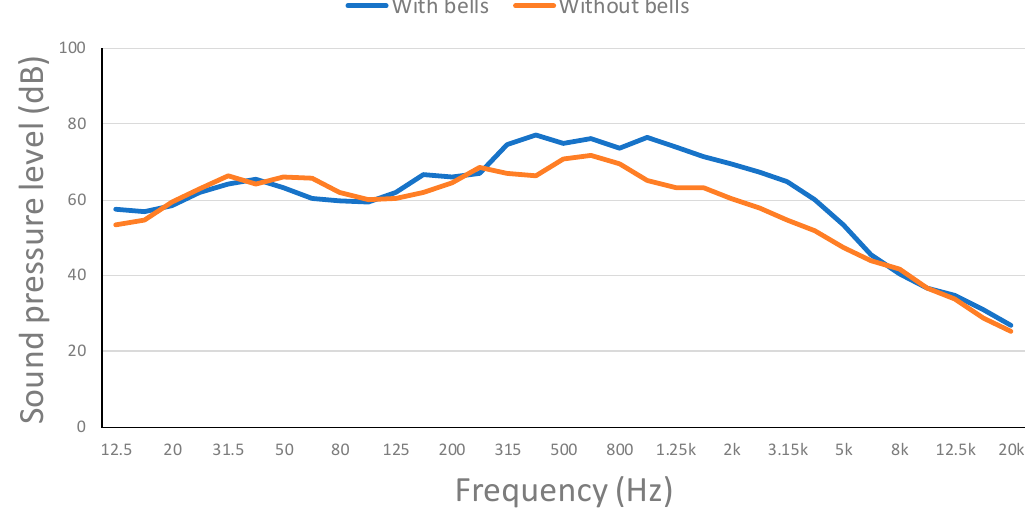
With bells Without bells